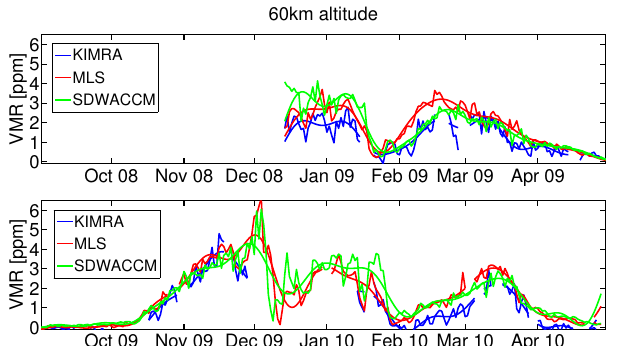
Fig. 4. Similar to Fig. 3, but for 60km altitude.